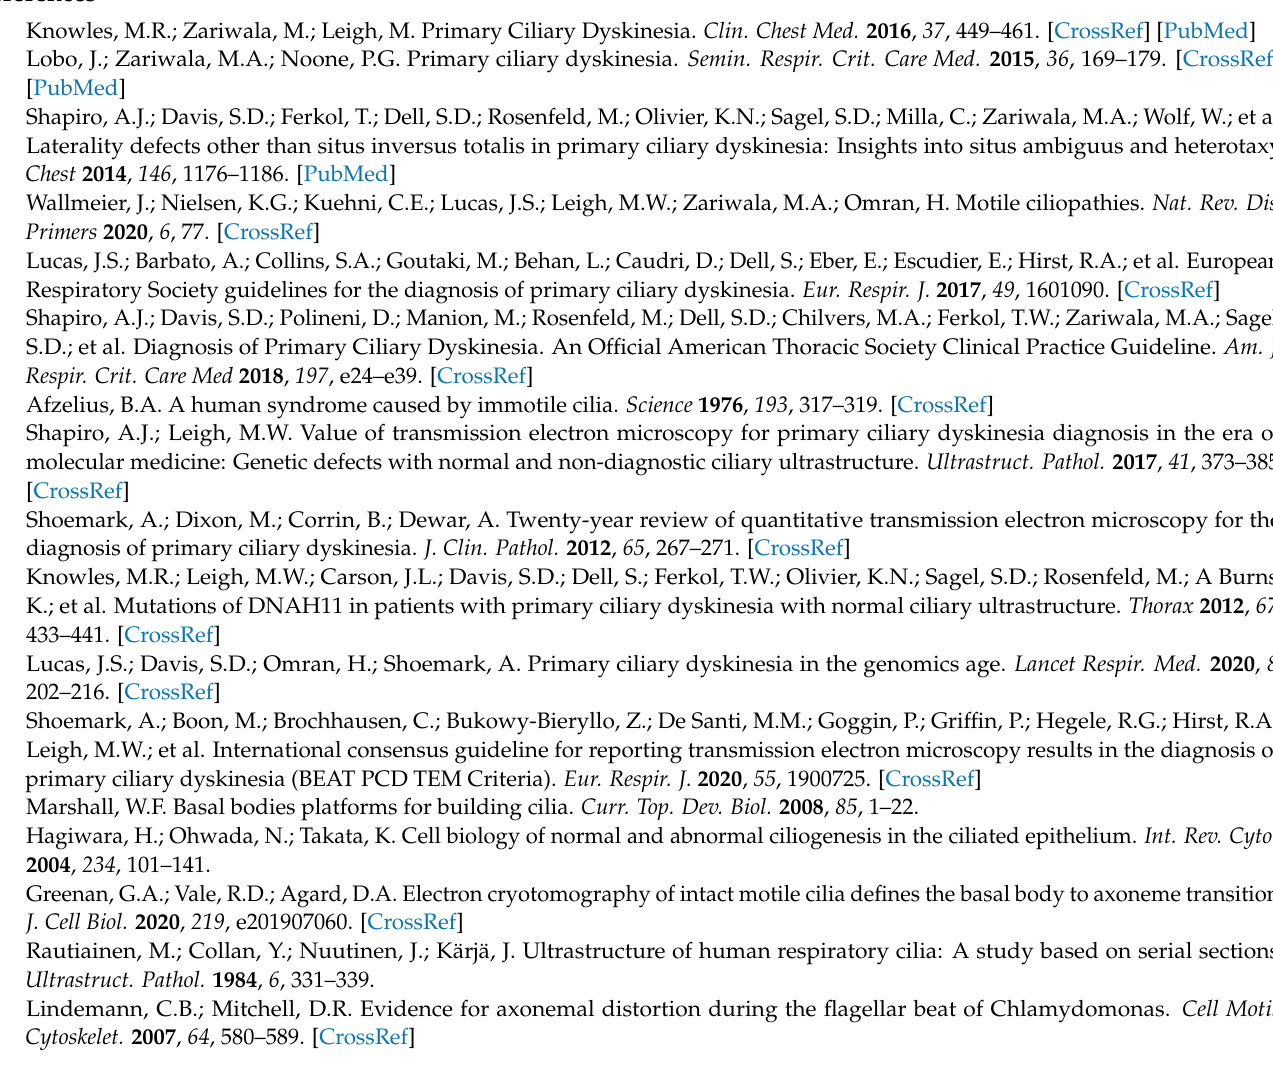
Table S5: Demographic and clinical characteristics of PCD